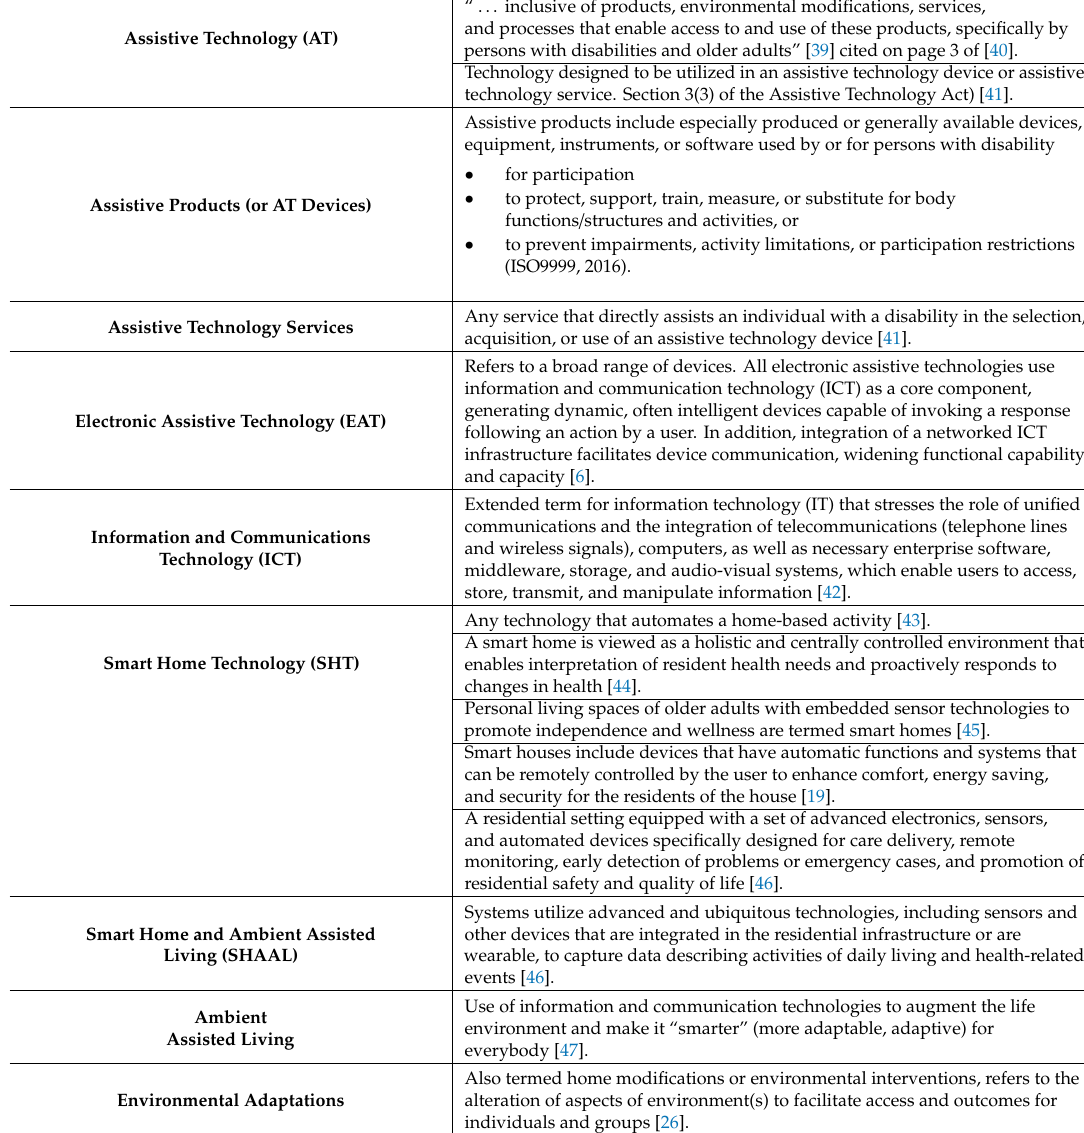
Table 1. Common terms and